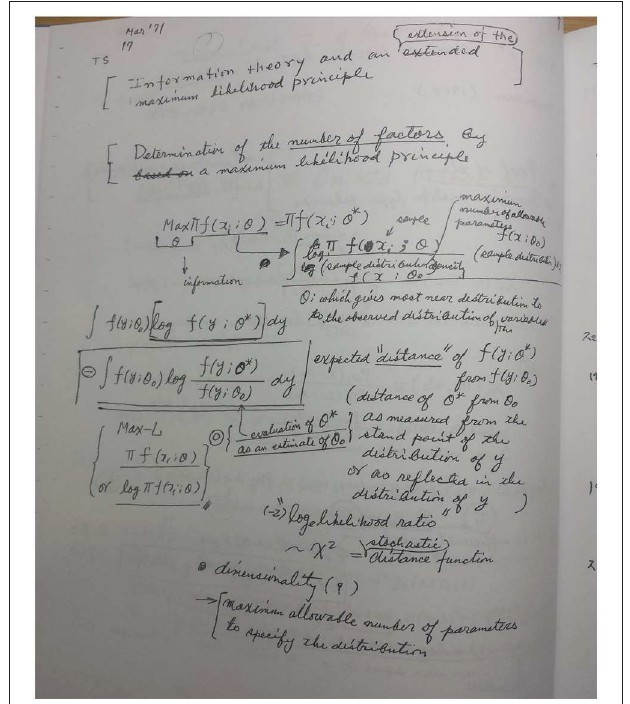
FIGURE 7 | Moment of discovery: page from Professor H. Akaike’s research notebook, written while he was commuting on the train in March 1971. Photocopy kindly provided by the Institute for Statistical Mathematics, Tachikawa,